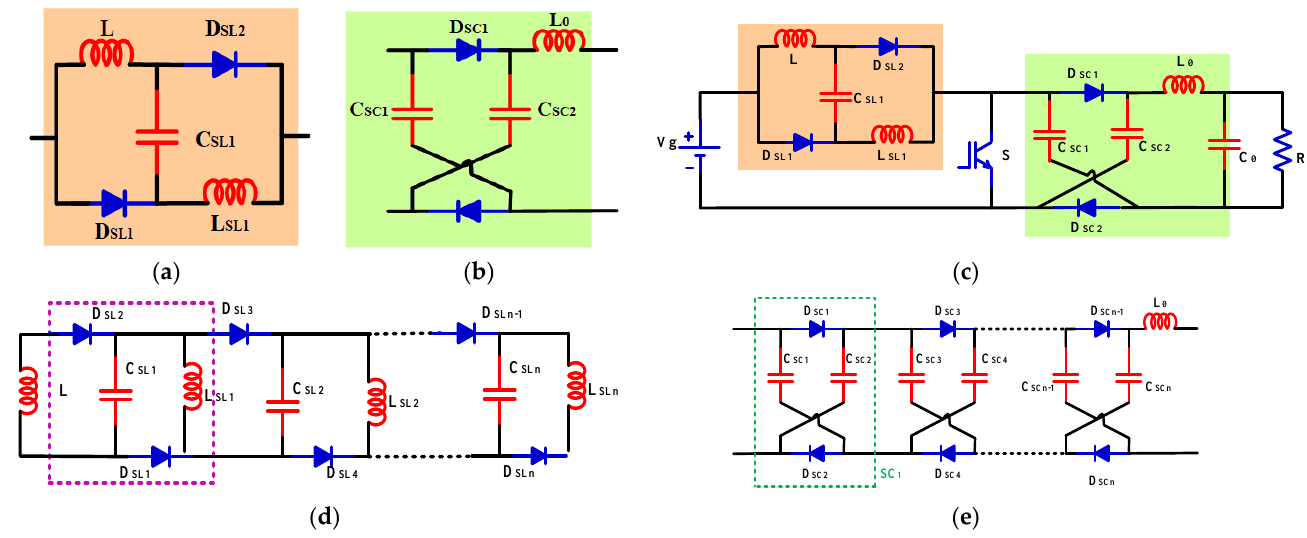
Figure 2. ( a ) SLcell; ( b ) SC cell; ( c ) PSLSC converter topology with single SL and SC cell; ( d ) Cascaded structure of Switched Inductor cell; ( e ) Cascaded structure of Switched Capacitor cell.